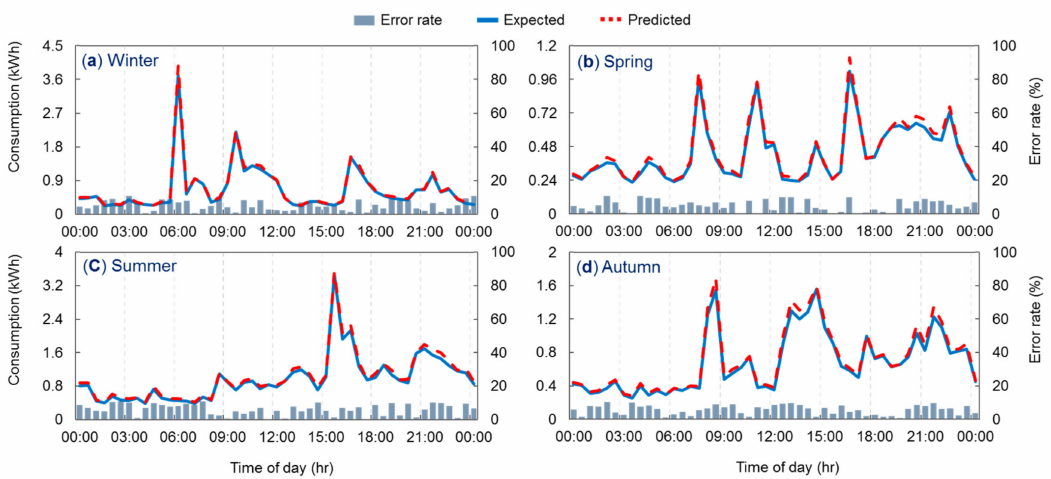
Figure 8. Comparison between the actual and predicted electricity consumption for the training results of ANN4 for a typical day in four seasons: ( a ) winter; ( b ) spring; ( c ) summer; and ( d )